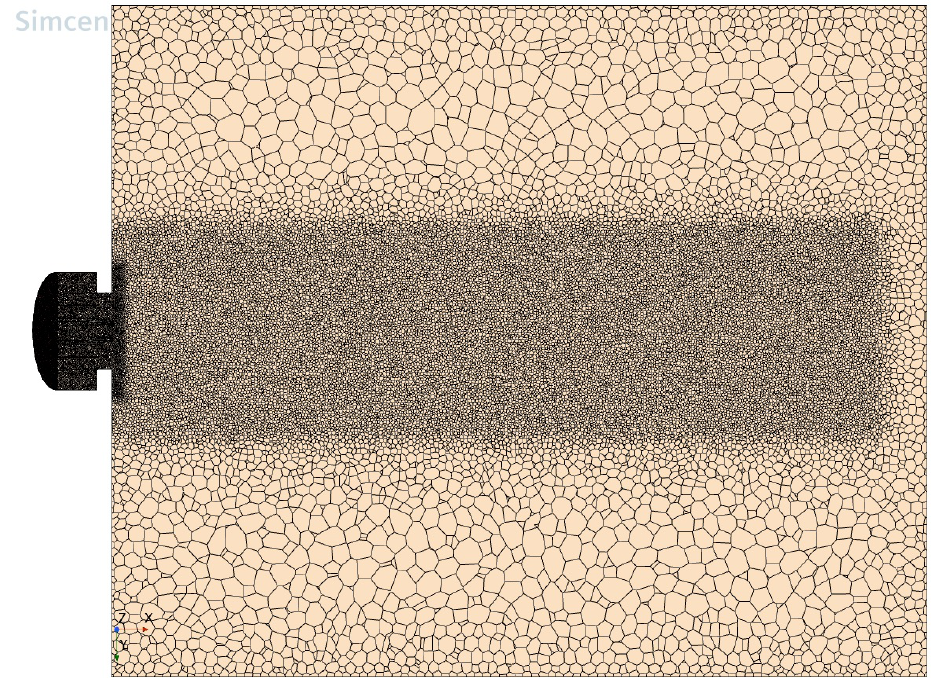
Figure 3. Calculation grid of the study area of the simulated combustion chamber with one burner device type, GMU-45.